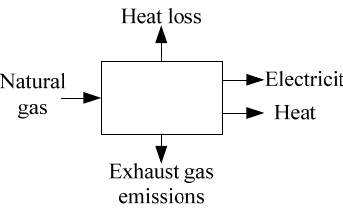
Figure 1. Single input and multi ‐ output (SIMO) model of combined heat and power (CHP).